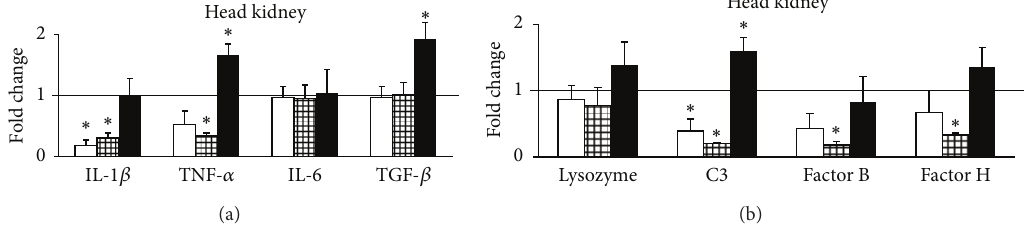
Figure 3: Real-time RT-qPCR analysis of IL-1 𝛽 , TNF- 𝛼 , IL-6, TGF- 𝛽 (a), lysozyme, C3, factor B, and factor H (b) in the head kidney of O. mykiss 1 (open bars), 5 (gridded bars), and 10 (closed bars) days after ip implantation of coconut oil alone (control) or containing 50 𝜇 g/g bw cortisol. Relative expression levels were normalized to 18S rRNA and fold changes were calculated against control. Values represent the means and SEM ( 𝑛 = 6 per group). Significant differences are highlighted as ∗ versus control ( 𝑃 < 0.05 ). The horizontal line originating at 𝑦 = 1 denotes the control group against which the expression was compared.